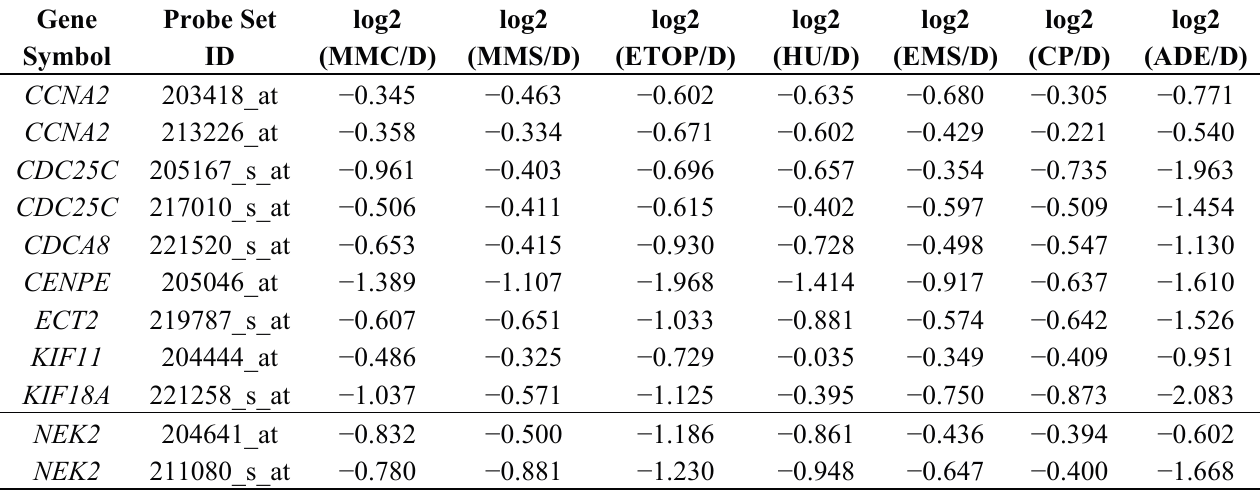
Shown are the log base 2 value of the ratio of alternations in the expression of eight genes to the mean of the corresponding control, DMSO. MMC, mitomycin C; MMS, methyl methanesulfonate; ETOP,